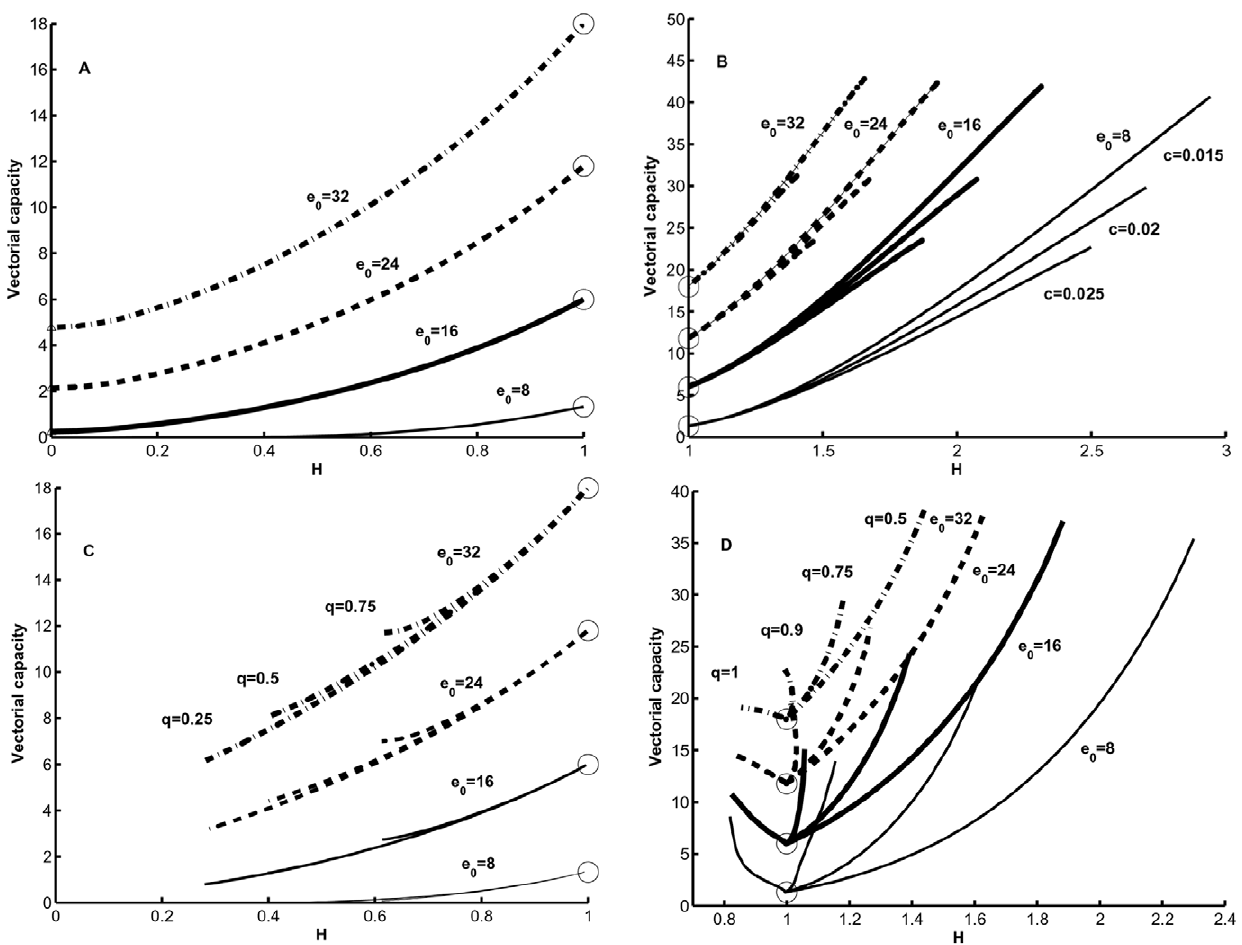
Figure 4. Vectorial capacity versus entropy H for different values of mean life span e 0 . (A) Gompertz’s, (B) declining, (C) U-shaped, and (D) unimodal mortality models. For each model, age-independent mortality for each life span is noted by an open circle.